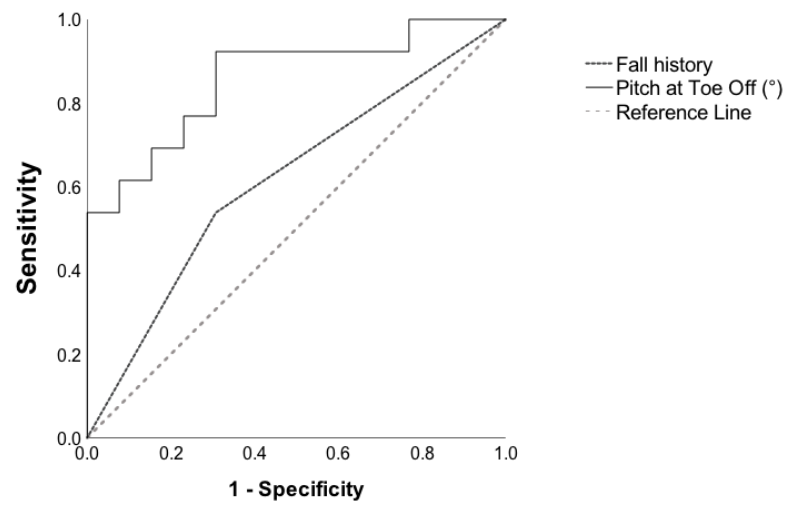
Figure 3. Receiver operating characteristic for fall history and pitch at toe-off angle to classify future fallers from non-fallers.